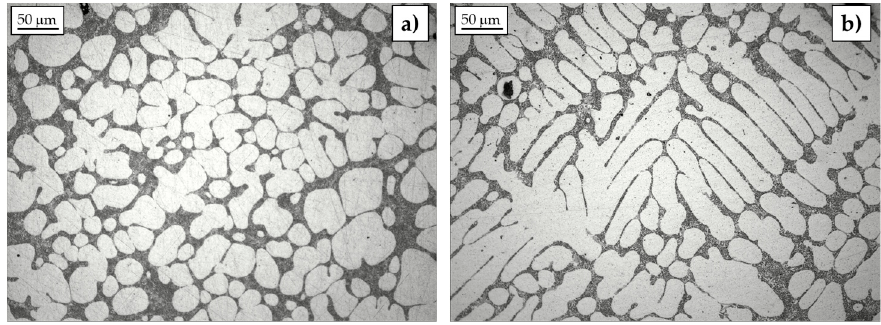
Figure 4. Typical microstructures of AlSi7 component ( a ) semi-solid cast and ( b ) conventionally cast.